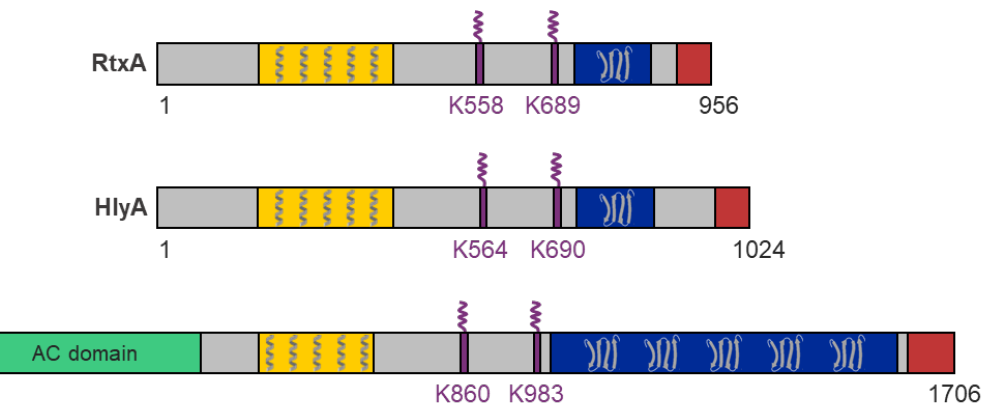
Figure 1. The structural representation of the RTX toxins RtxA, HlyA, and CyaA. The RtxA, HlyA, and CyaA toxins consist of a pore-forming domain (yellow), an acylated segment with two posttranslationally acylated lysine residues (purple), an RTX domain (blue), and a C-terminal secretion signal (red). Unlike other RTX toxins, CyaA contains a unique adenylate cyclase domain (green). RtxA belongs to a broad family of pore-forming RTX cytotoxins secreted by